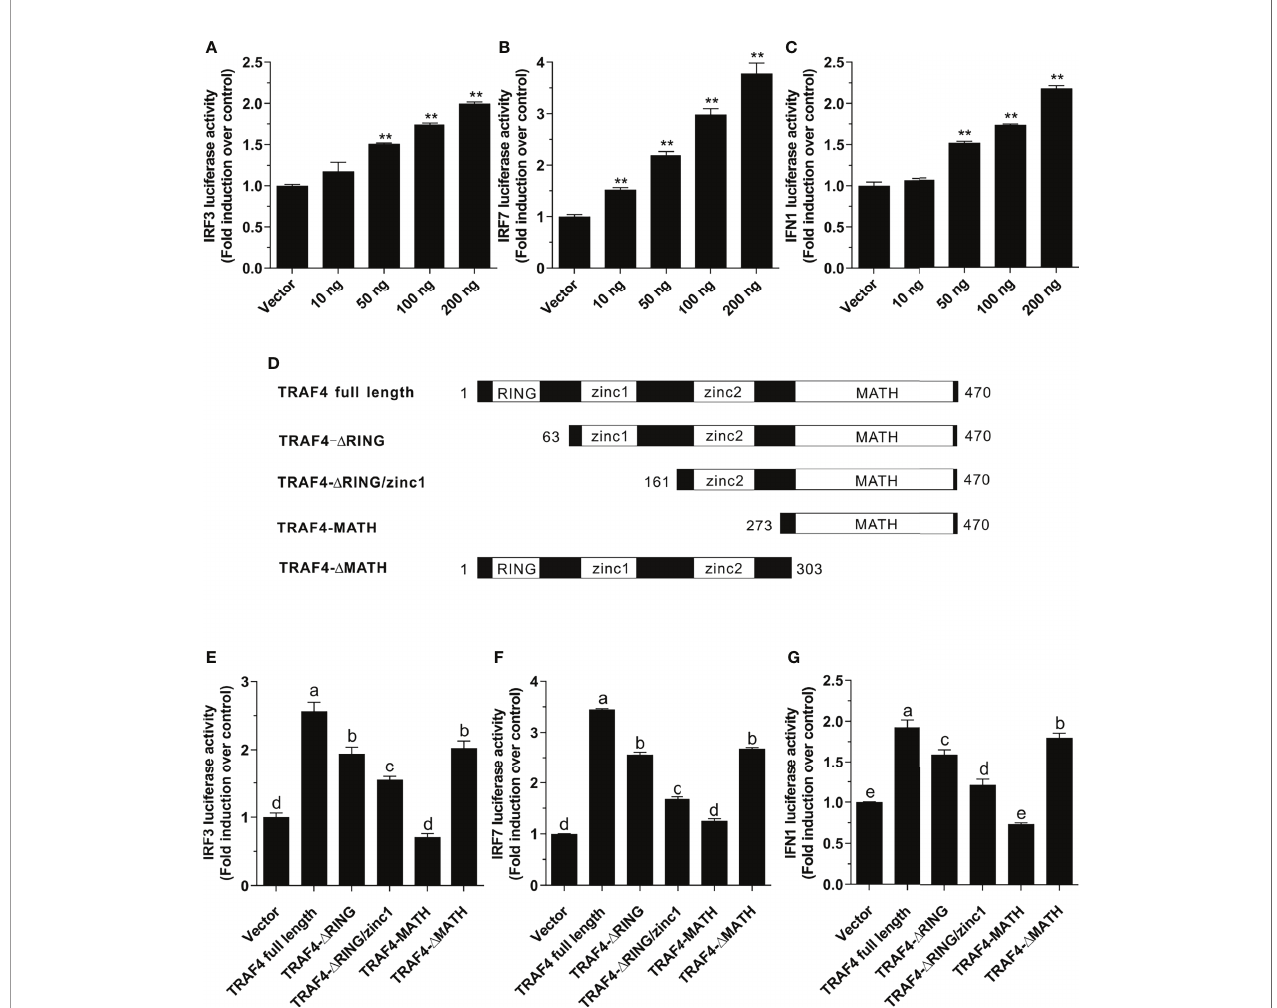
FIGURE 5 | Function of Lc -TRAF4 and its truncated forms in IRF3, IRF7, and IFN1 promoter activation. (A) Induction of IRF3 promoter activity by Lc -TRAF4. (B) Induction of IRF7 promoter activity by Lc -TRAF4. (C) Induction of IFN1 promoter activity by Lc -TRAF4. HEK 293T cells seeded in 24-well plates were co-transfected with 100 ng of pGL4-IRF3-pro, pGL4-IRF7-pro or pGL4-IFN1-pro, 10 ng pRL-TK together with increasing amounts of pcDNA3.1-TRAF4 or pcDNA3.1 (vector control). At 24 hpt, the cells were collected to detect luciferase activity. (D) Schematic representation of Lc -TRAF4 full-length and the truncated forms used in this study. (E) Induction of IRF3 promoter activity by Lc -TRAF4 and its truncated forms. (F) Induction of IRF7 promoter activation by Lc -TRAF4 and its truncated forms. (G) Induction of IFN1 promoter activity by Lc -TRAF4 and its truncated forms. Brie fl y, HEK 293T cells seeded in 24-well plates were co-transfected with 100 ng of pGL4-IRF3-pro, pGL4-IRF7- pro or pGL4-IFN1-pro, 10 ng pRL-TK together with 100 ng of pcDNA3.1-TRAF4 or Lc -TRAF4 truncated forms expression plasmids including pcDNA3.1-TRAF4- D RING, pcDNA3.1-TRAF4- D RING/zinc1, pcDNA3.1-TRAF4-MATH, pcDNA3.1-TRAF4- D MATH or pcDNA3.1 empty vector as control. At 24 hpt, the cells were harvested for detection of luciferase activity. All data were shown as mean ± SE from three independent experiments, with bars representing SE. Different superscripts indicate statistically different results (P < 0.05), and the same superscript indicates no statistical differences between groups. * P < 0.05, ** P <